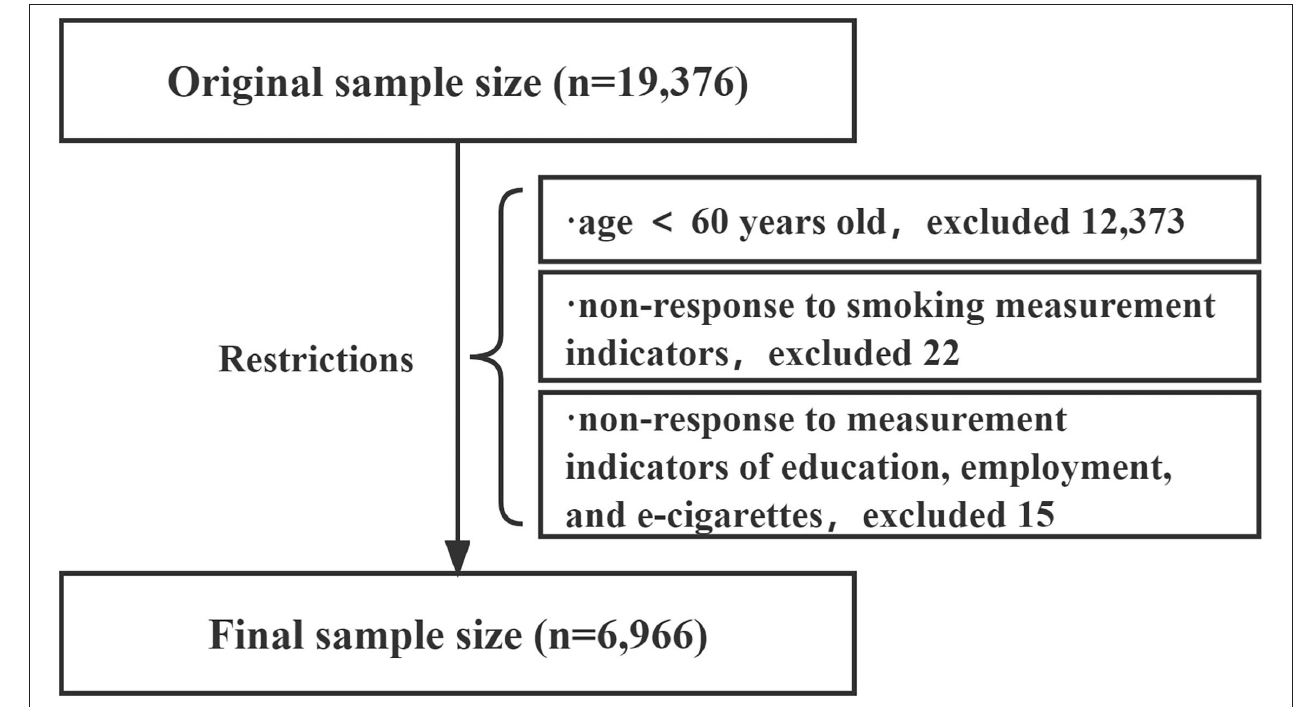
FIGURE 1 | Flowchart of study